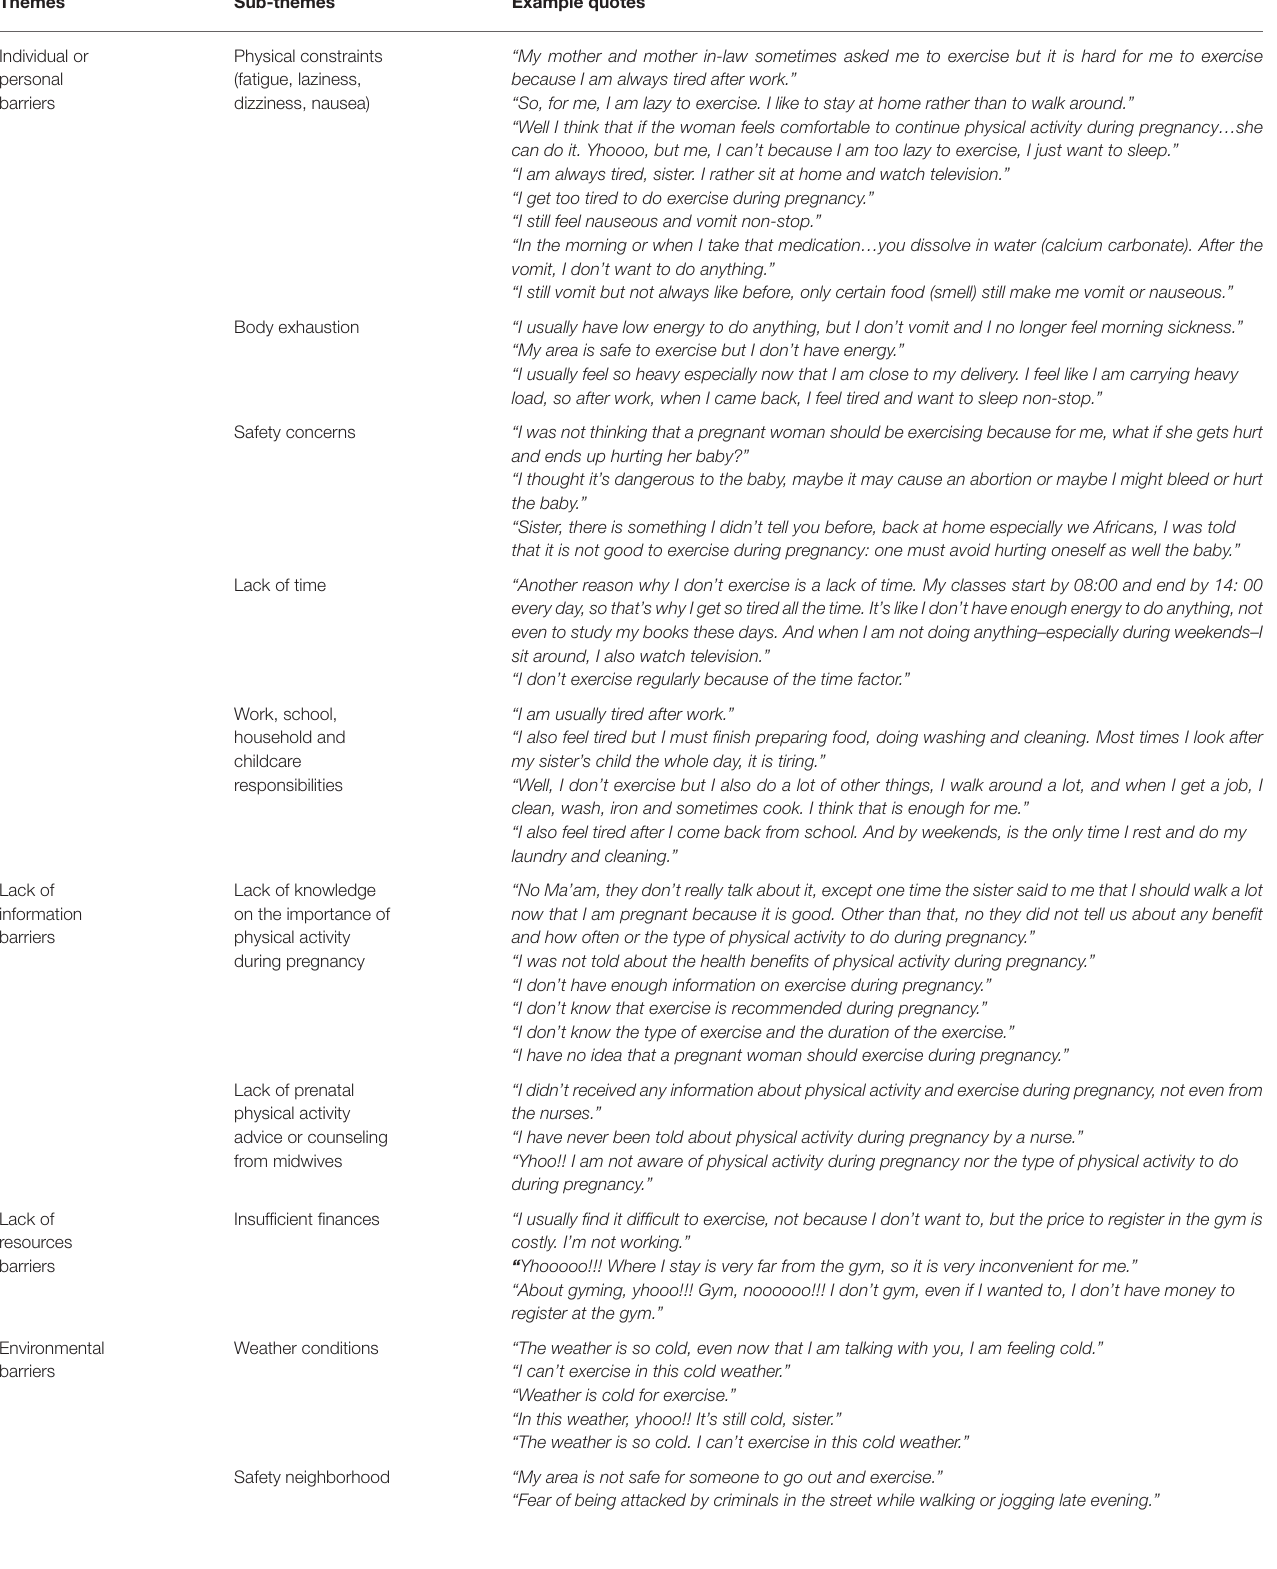
TABLE 2 | Themes and sub-themes reflecting the responses of pregnant women regarding barriers to physical activity during pregnancy.